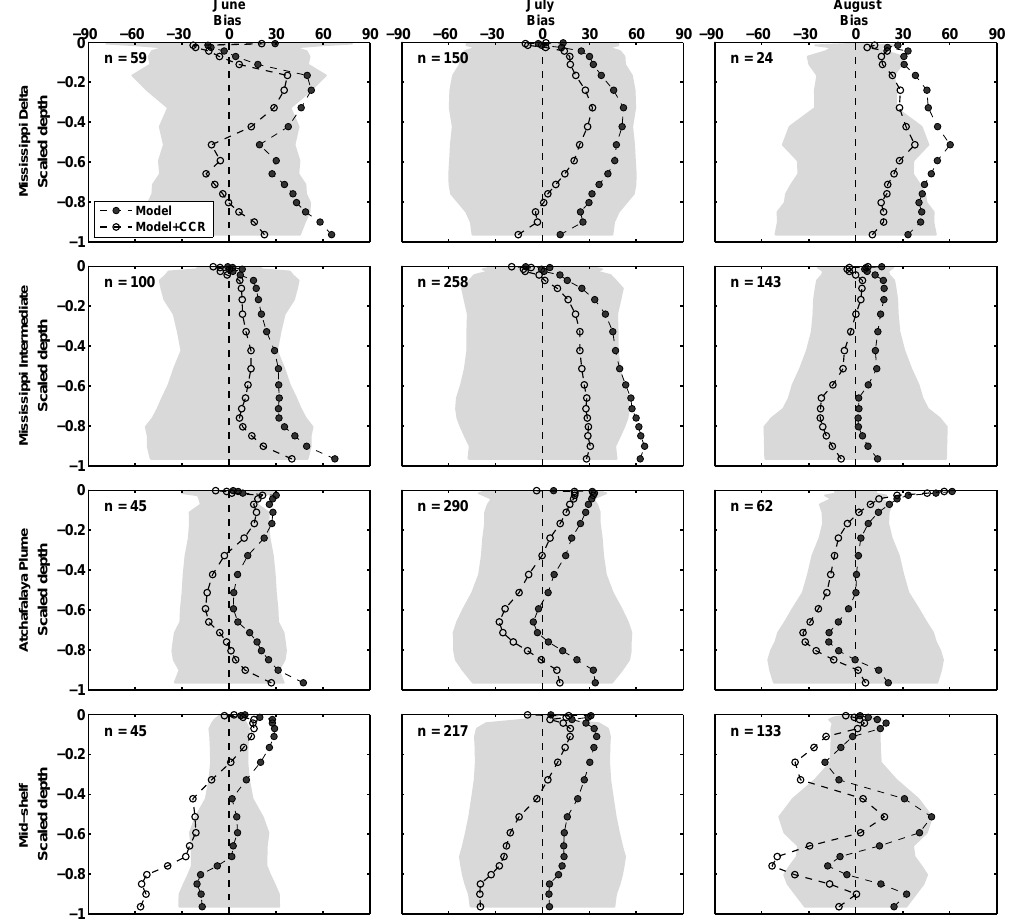
Figure 5. Vertical profiles of model bias (model minus observations, mmolO 2 m − 3 ) in dissolved oxygen (DO) calculated from 2004 to 2007 for June to August in the four sub-regions. The vertical axis is the scaled depth, where 0 corresponds to the surface and − 1 to the bottom. The light-grey areas represent the standard deviation in the observations. Observations are from Rabalais et al. (2007), Lehrter et al. (2009, 2012), Murrell et al. (2014), and the MCH